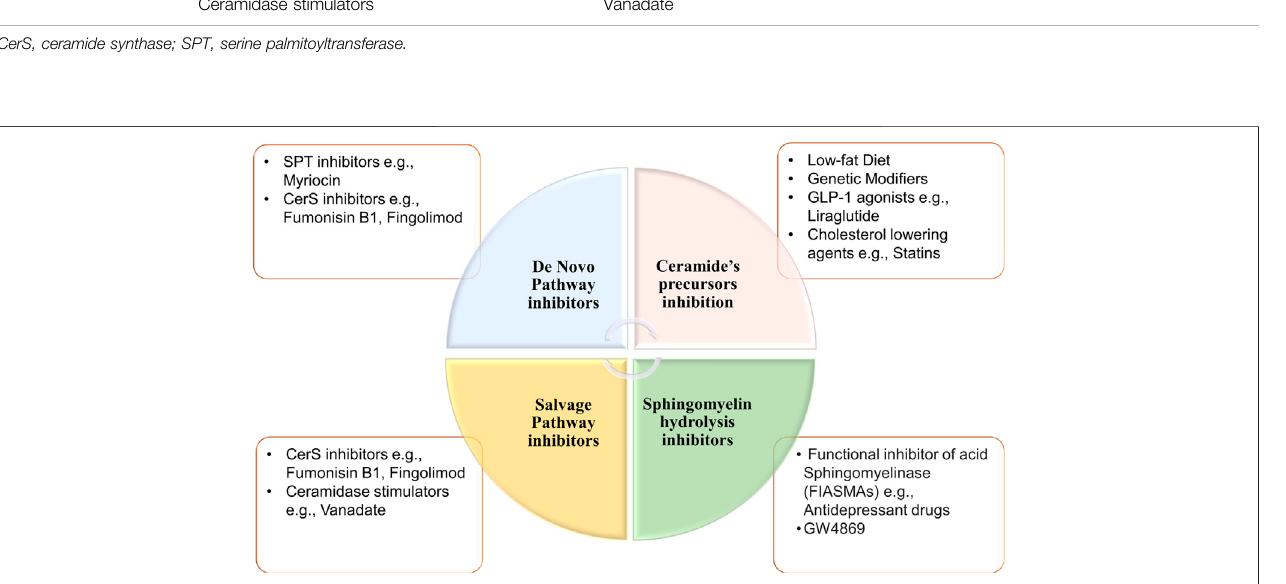
Frontiers in Cell and Developmental Biology |